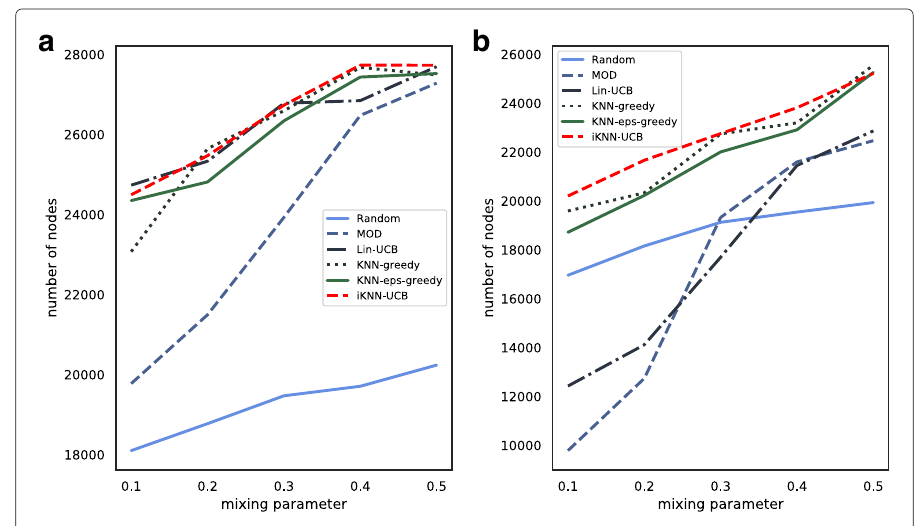
Fig. 4 Performance on synthetic networks generated by LFR benchmark model. a RN sample b BFS sample